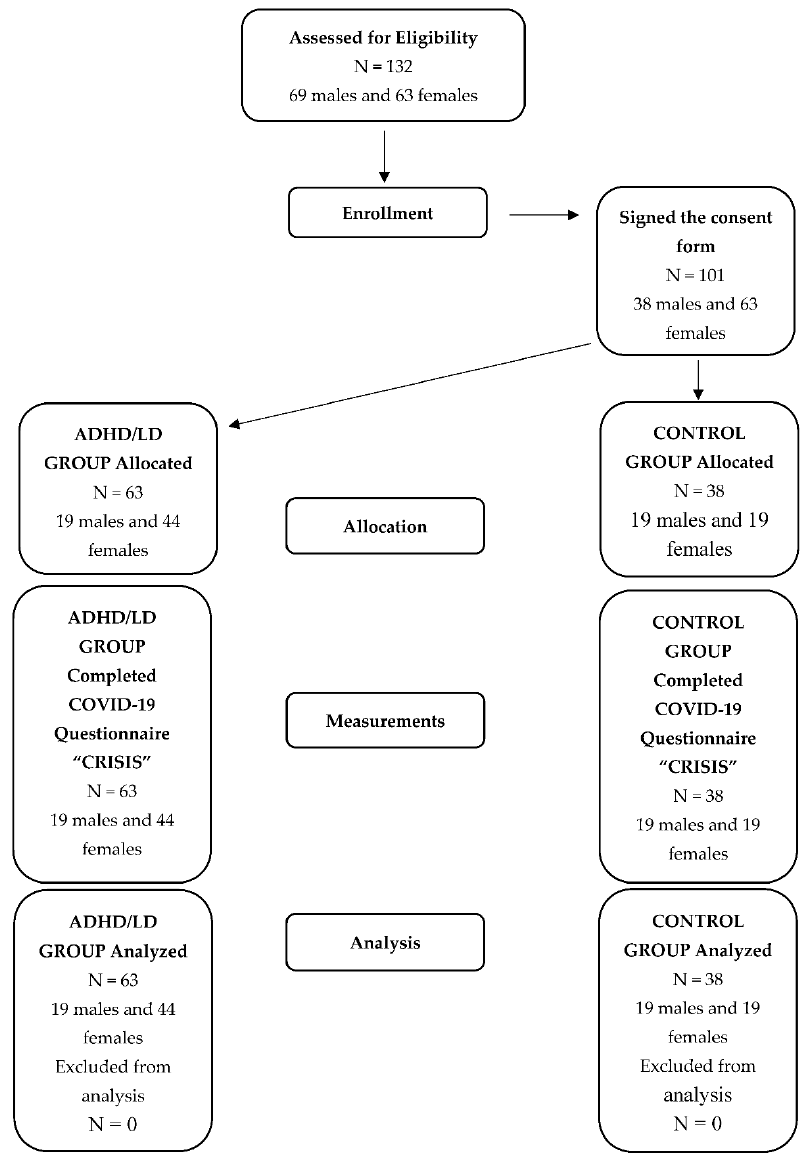
Figure 1. Sampling flowchart.